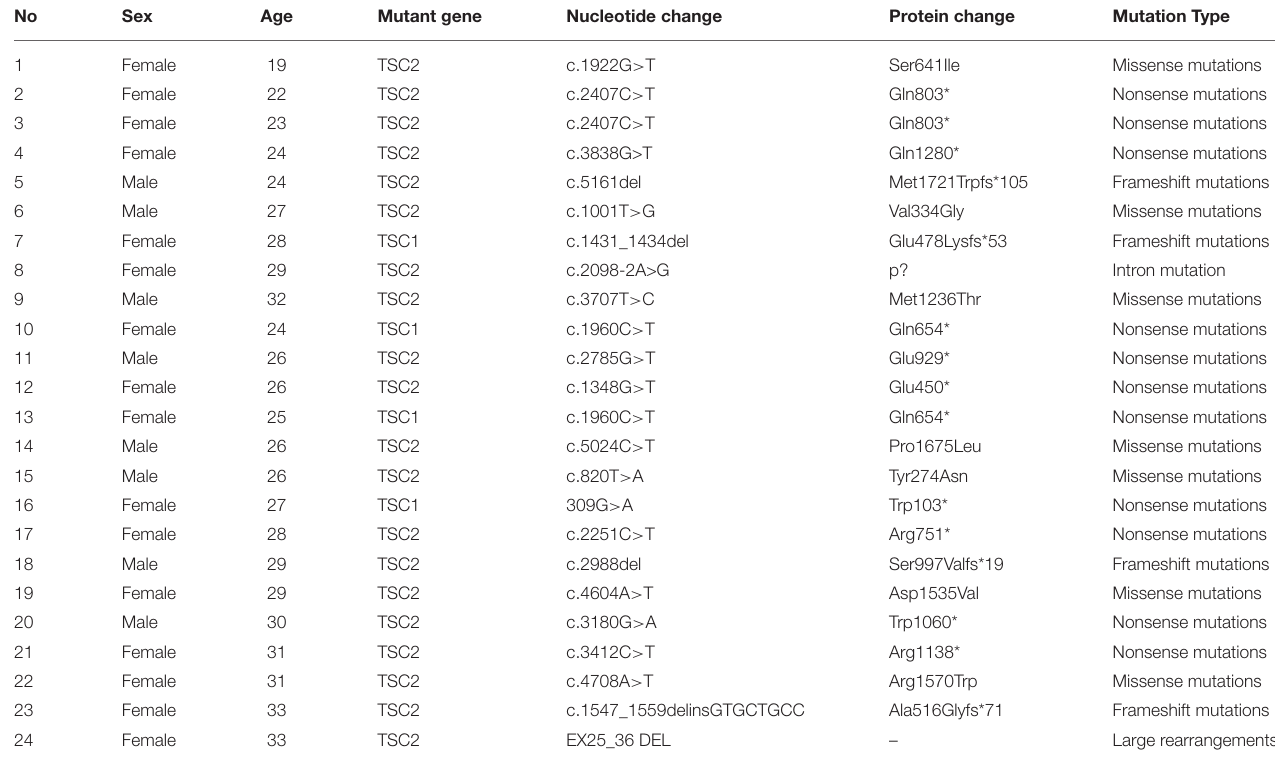
TABLE 2 | Mutations detected by next-generation sequencing.